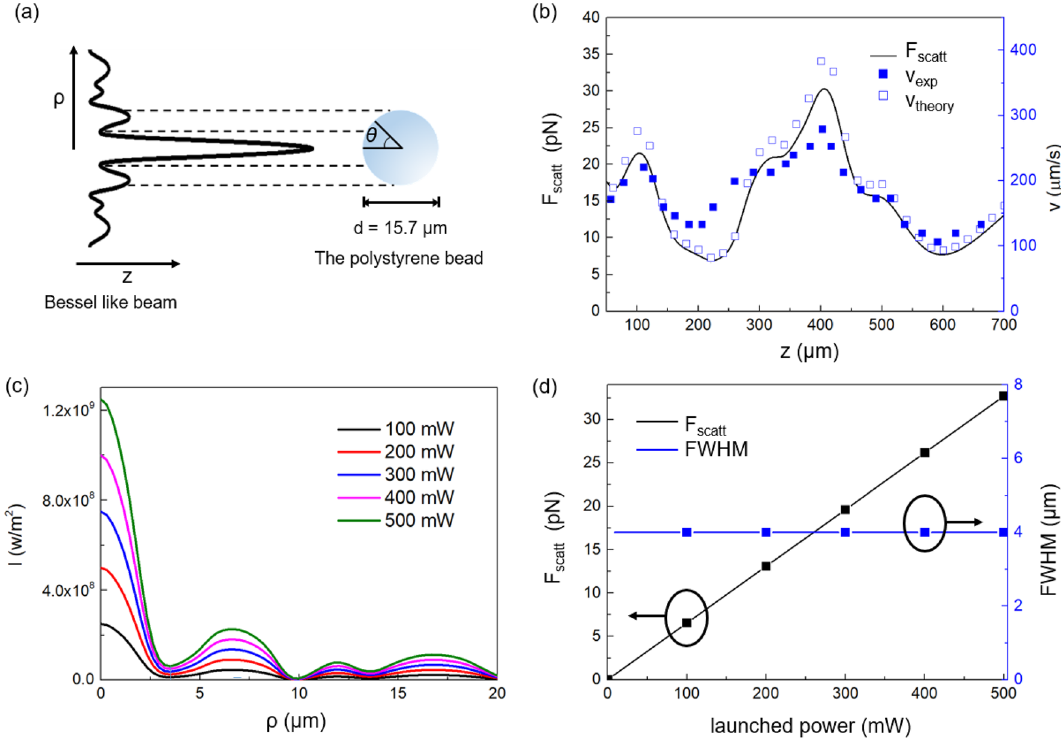
Figure 6. The scattering force analyses for the single fiber optic Bessel-like beam using BPM. ( a ) Relative dimension of the Bessel-like beam and the polystyrene bead. ( b ) The scattering force, F scatt , on the bead and its terminal speed as a function of the axial distance, z. The launched laser power was 342 mW. Experimentally measured speed, v exp , and v theory , estimated by BPM are compared. ( c ) The transverse intensity profile of the Bessel-like beam as a function of the radial coordinate for various launched laser powers calculated by using BPM. ( d ) F scatt and FWHM of the central peak as a function of the launched laser power. In ( c ) and ( d ), we assumed z = 100